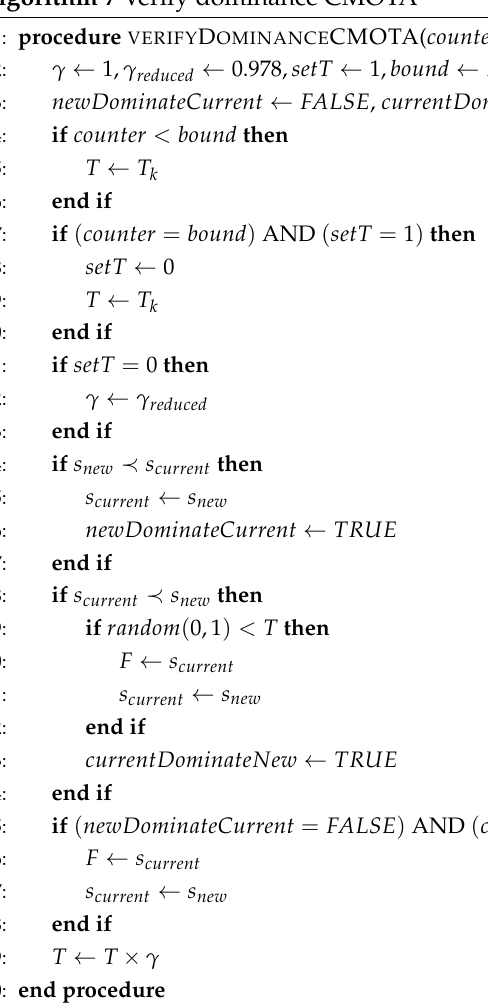
Algorithm 7 Verify dominance